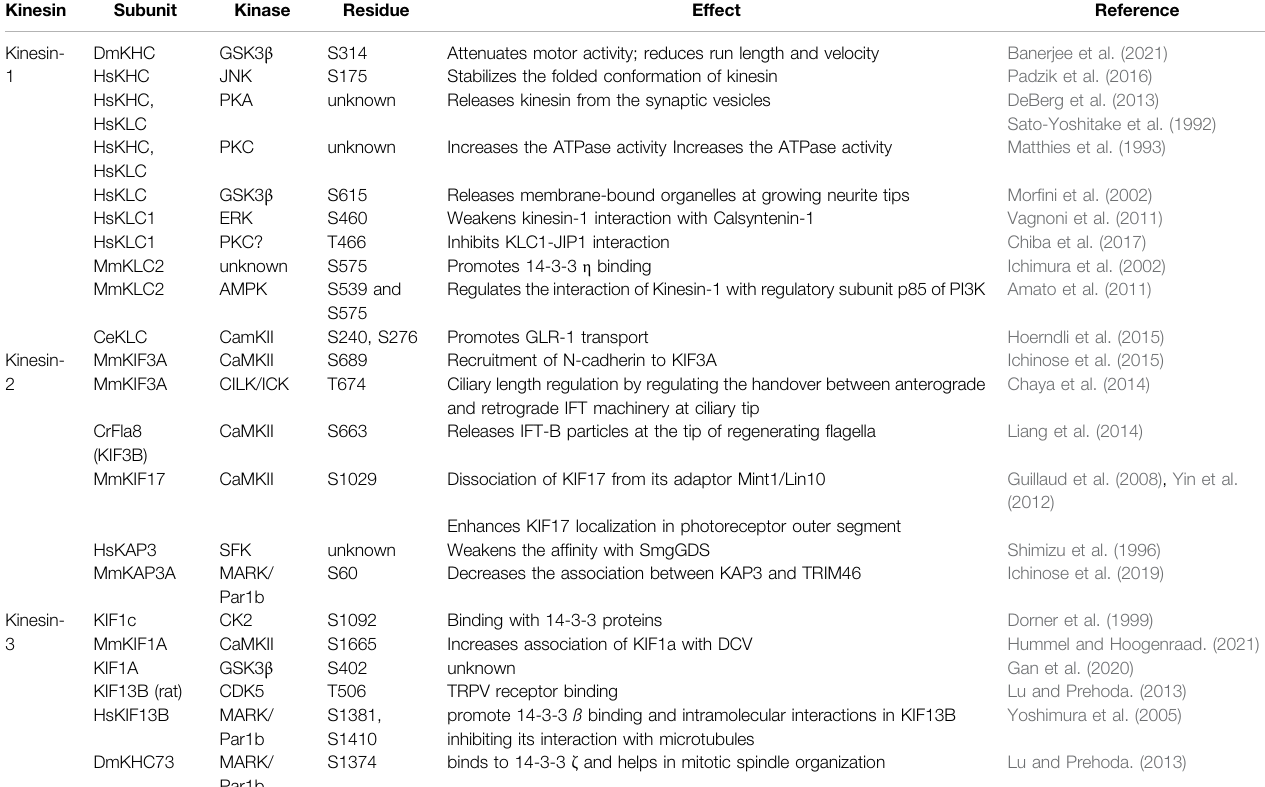
TABLE 1 | List of kinases that phosphorylate kinesins.